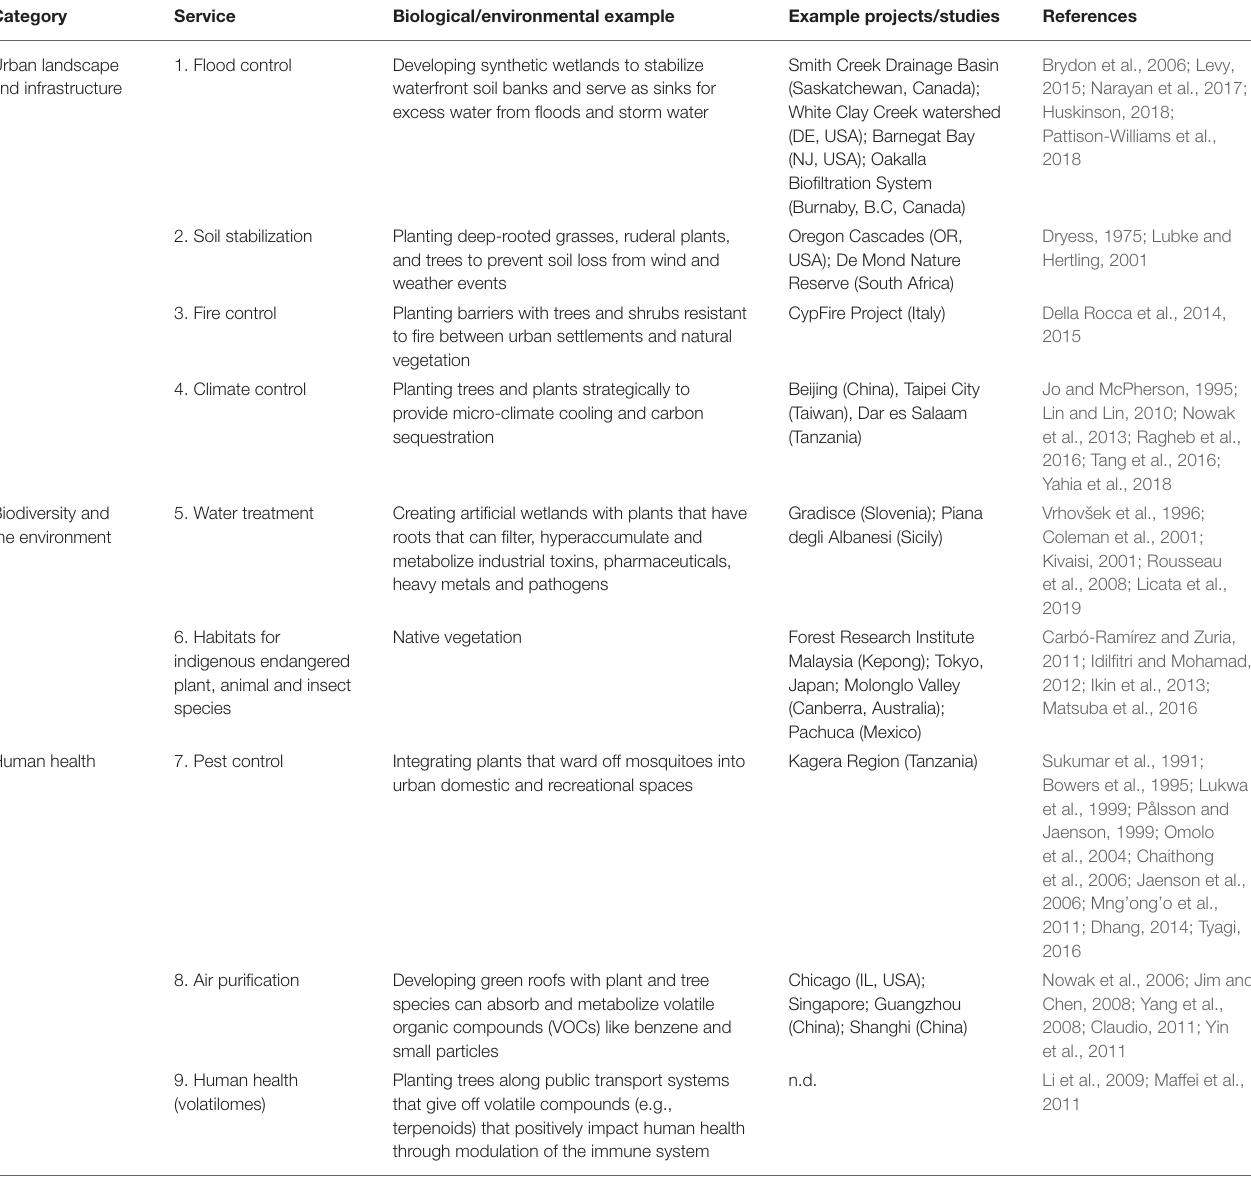
TABLE 1 | Services provided by Function-Specific Plant Systems